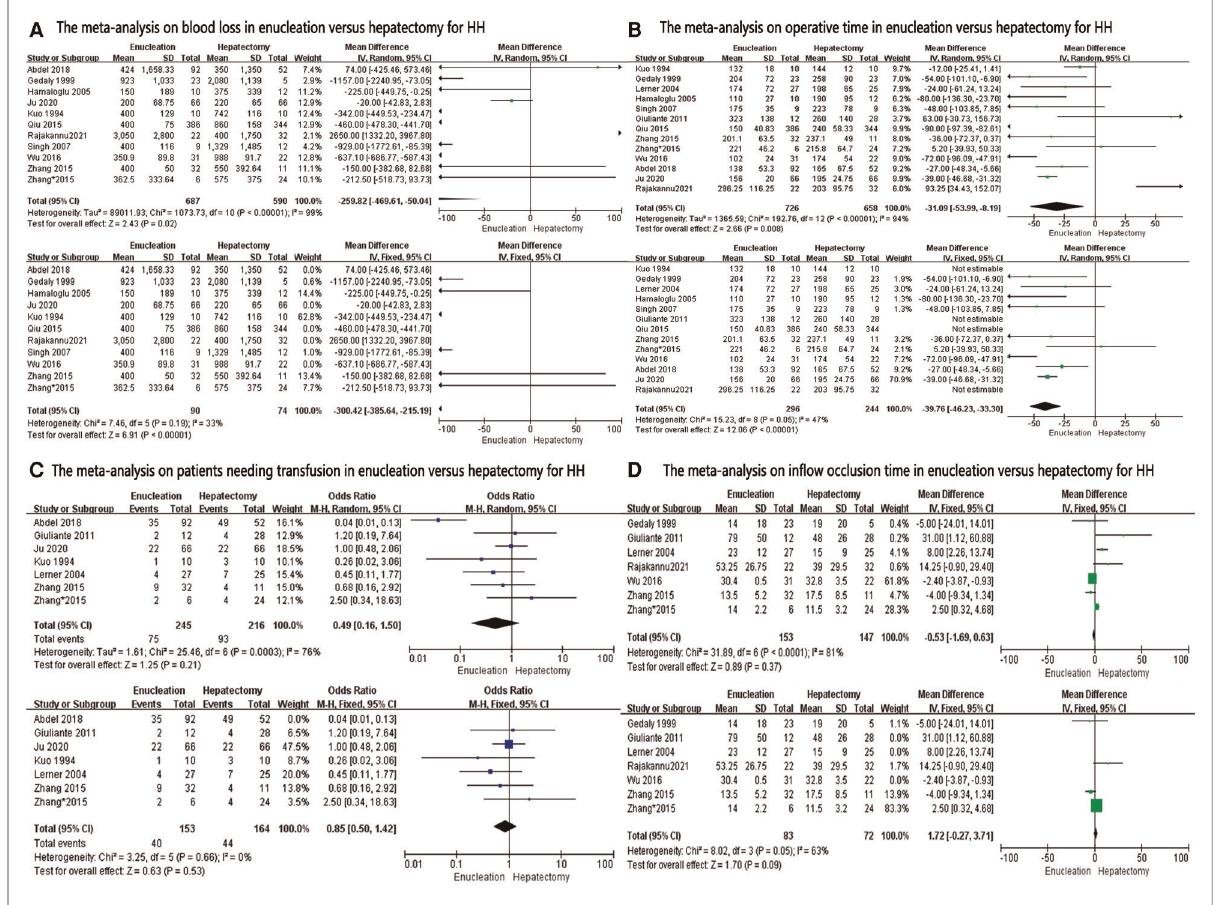
FIGURE 2 The forest plots for operative outcomes in enucleation versus hepatectomy for